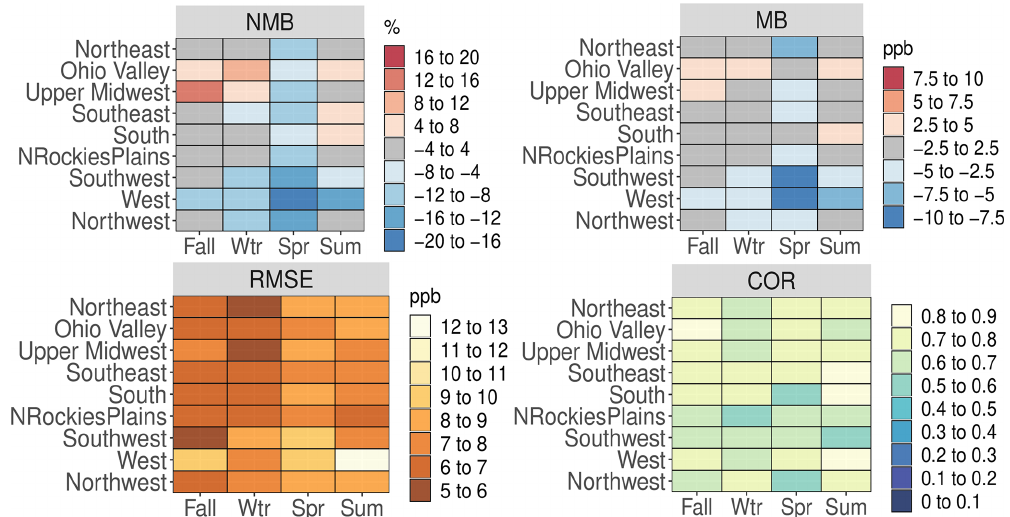
Figure 1. NMB (%), MB (ppbv), RMSE (ppbv), and Pearson correlation coefficient values for MDA8 O 3 for all AQS sites based on season and NOAA climate region for the CMAQ521 simulation.